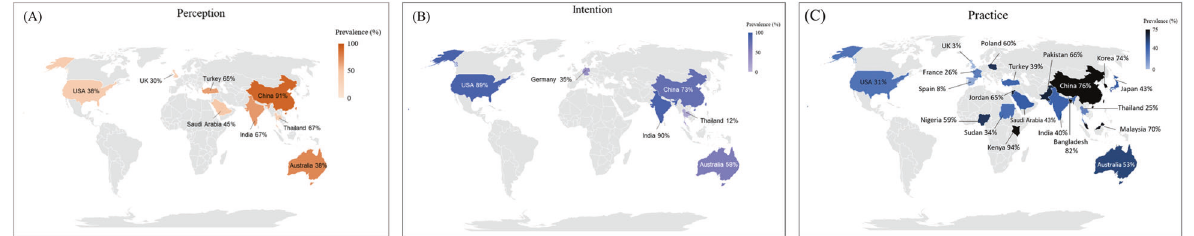
Fig. 4 Global prevalence of perception, intention, and practice of facemask use among the general population. A Perceived ef fi cacy of facemask for preventing respiratory infection. B Intention of facemask use for preventing respiratory infection. C Practice of facemask use for preventing respiratory infection during the